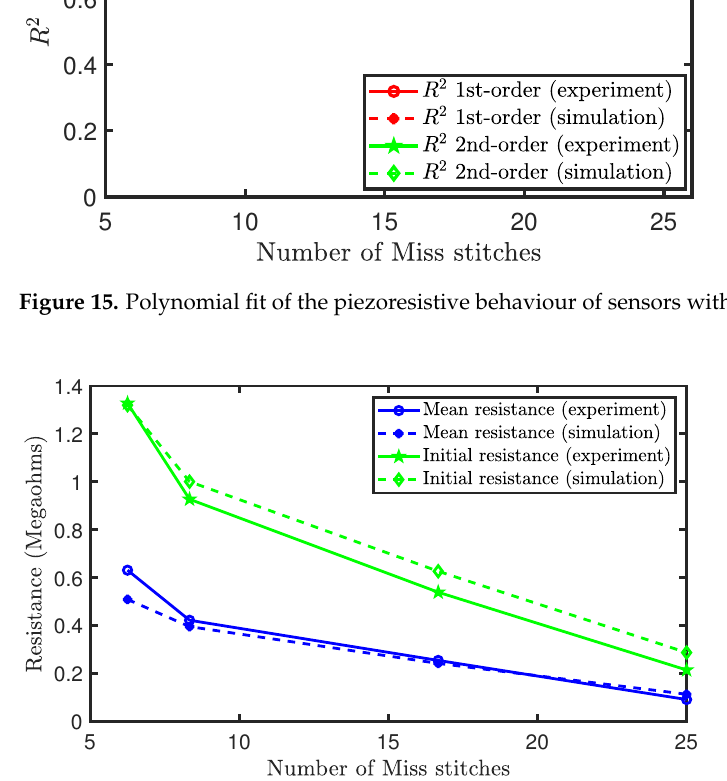
Figure 16. Initial and mean resistances of sensors with miss